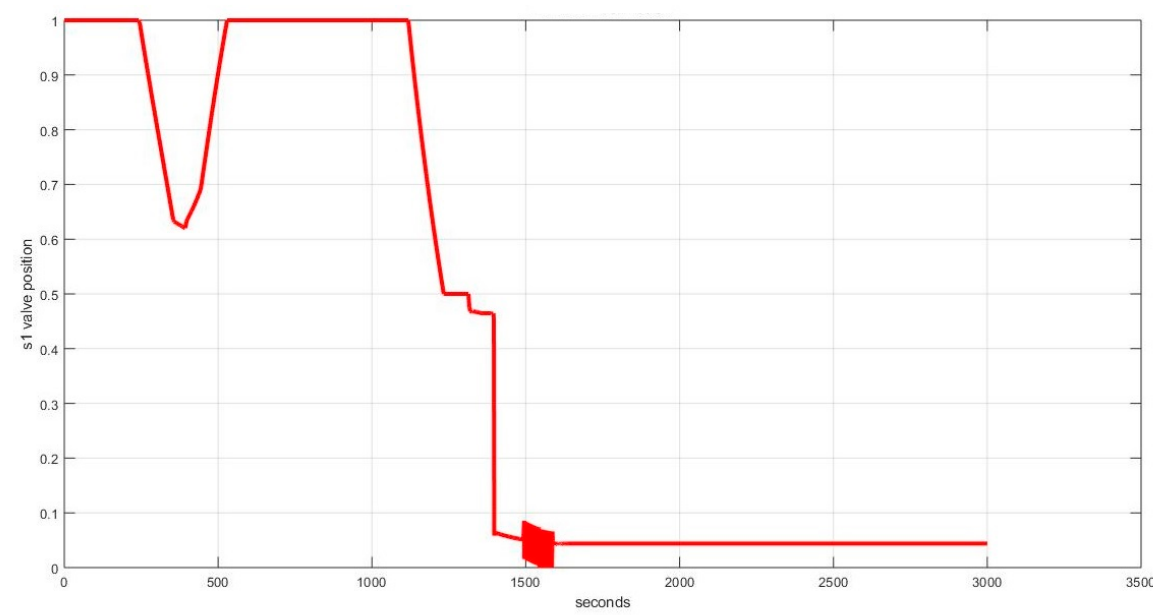
Figure 11. s1 control variable indicating the valve position for the case in Figure 9.